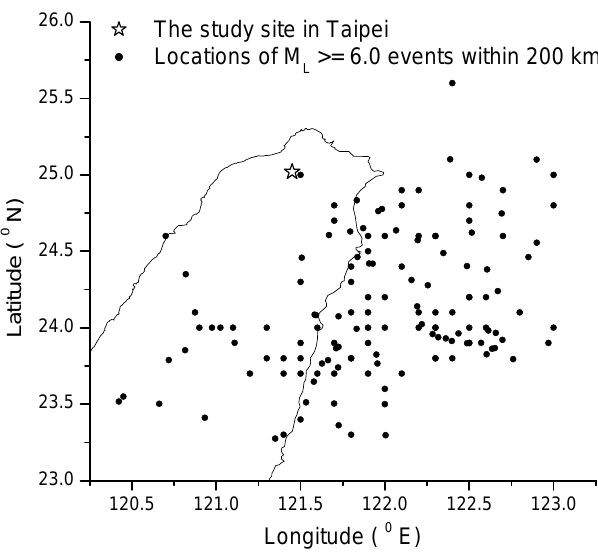
Fig. 5. The large earthquakes above M L = 6.0 within a distance of 200 km from the study site in Taipei.